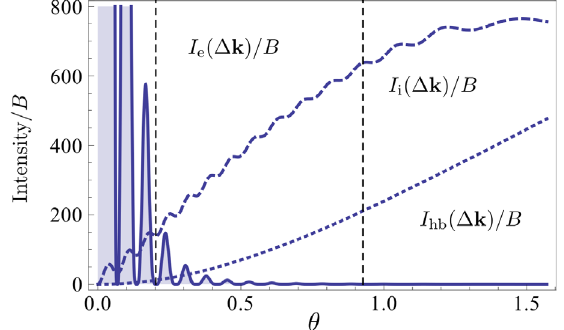
correlations.FIG. 15. Comparison of the angular distribution of the different components of the scattered light intensity at T ¼ 0 along the direction ϕ ¼ π = 4 . Here, the on-site interaction strength U ¼ 1 . 76 J and the order parameter m ¼ 0 . 16 ( m ≃ 0 . 13 ). We use RPA the same parameters as in Fig. 11. We show the MFT elastic component (solid line), the RPA inelastic intraband component (dashed line), and the inelastic interband component (dotted line). We schematically represent the position of a block and a NA ¼ 0 . 8 lens by vertical